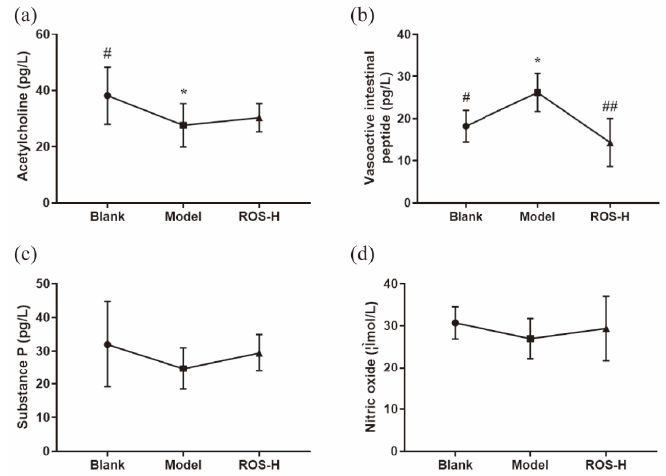
Figure 2. Effects of ROS on serum level of acetylcholine ( a ), vasoactive intestinal peptide ( b ), sub- stance P ( c ), and nitric oxide ( d ) in mice. Blank: distilled water treated; Model: Loperamide treated; ROS-L: low-dose ROS treated; ROS-M: medium-dose ROS treated; ROS-H: high-dose ROS treated. * p < 0.01 than in the blank group; # p < 0.05 and ## p < 0.01 than in the model group.